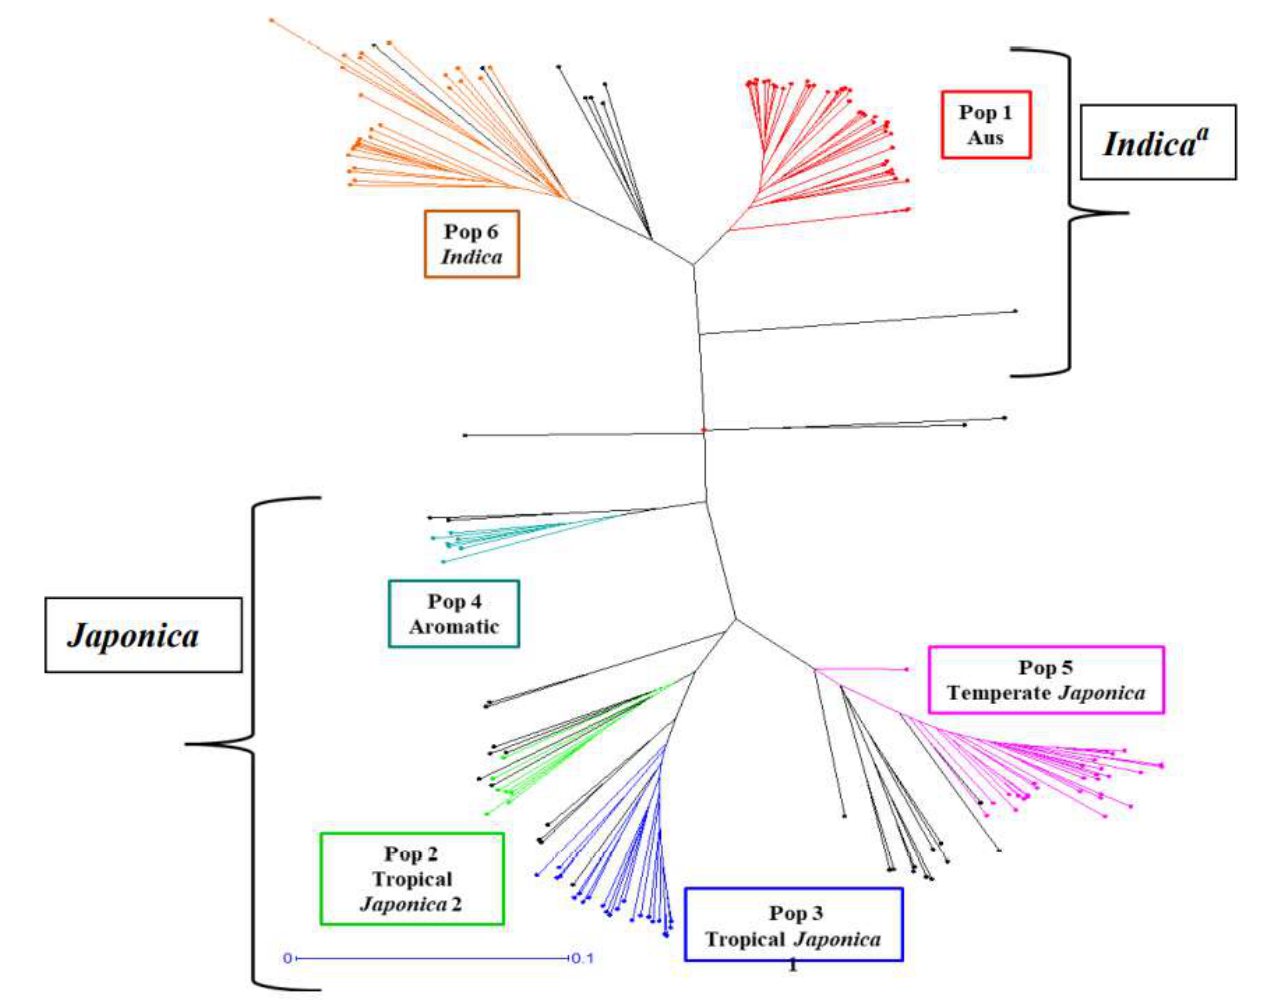
Figure 2. Cluster analysis of the rice germplasm used in this study, using the neighbor-joining method. Colors of the node indicate different subpopulations of the germplasm found by the STRUCTURE analysis. Black color nodes indicate admixed samples. N.B.: a = Subpopulations with close genetic distance are grouped either into “ Indica ” or “ Japonica ” subpopulation, two major subpopulations in rice.